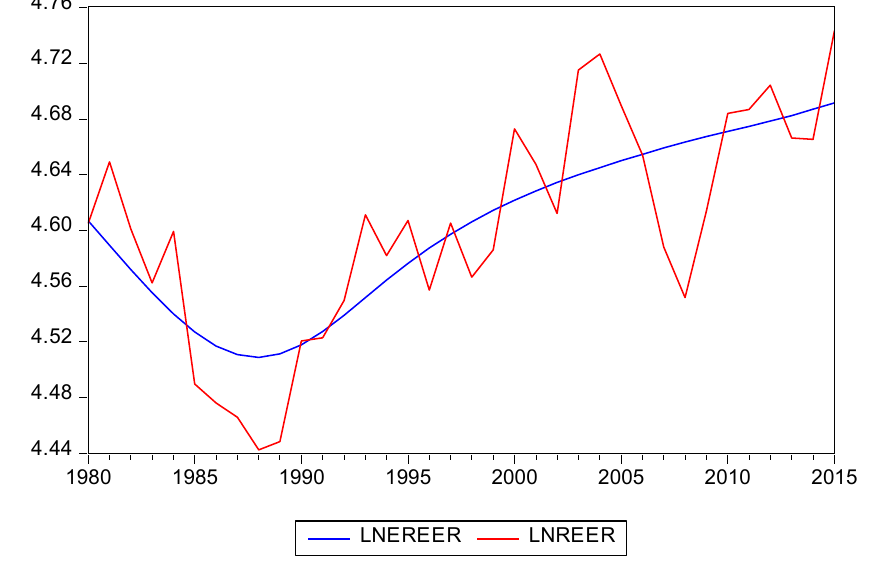
Figure 1. Botswana pula misalignment (1980–2015). Table 4. Causality between MISREER and its potential